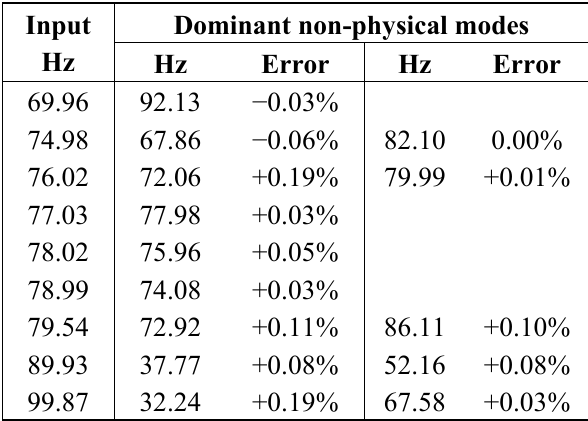
Table 3. Frequency Comparison of the Dominant Non-Physical Mode, Using High Speed Camera to Capture Vibration Exciter